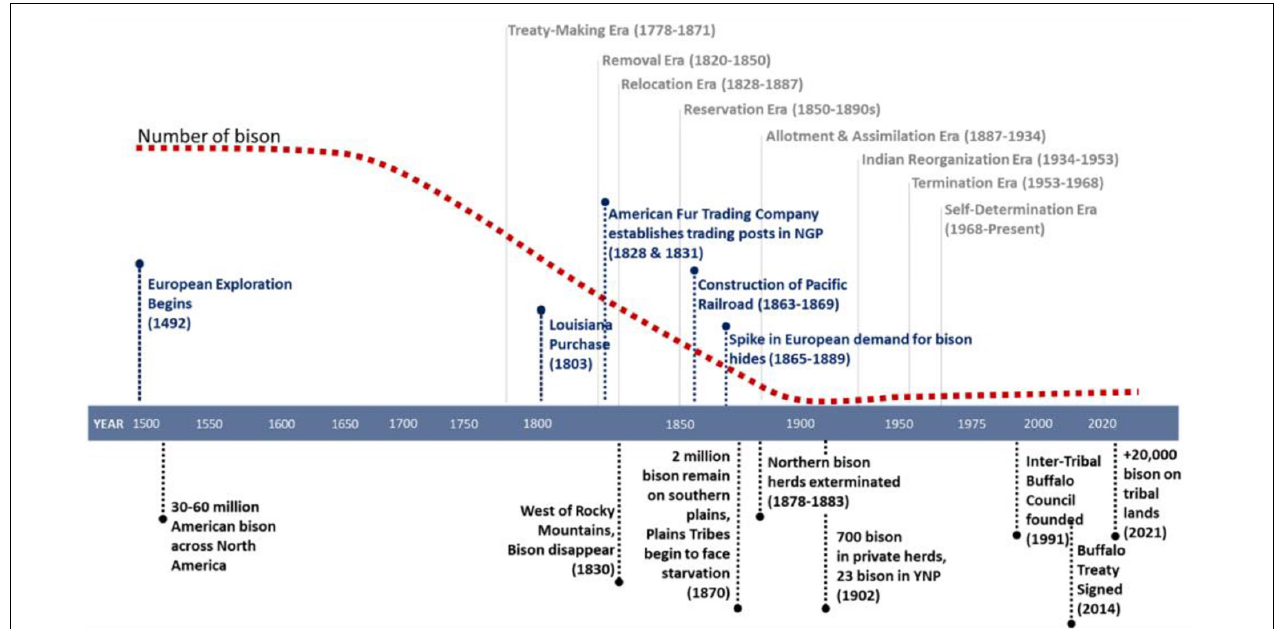
FIGURE 2 | Major events leading to decline of American bison ( Bison bison ) run in parallel with settler colonialism and the disenfranchisement of Plains people. Full details are given in Supplementary Materials (1) . Light gray lines differentiate between Native American eras during European expansions to the West. Dashed blue lines highlight key colonial events that contributed to decline of bison. Black dashed lines highlight key events in the near extermination of American bison (beginning with population estimate). Red dashed line illustrates the decline of bison from 30 to 60 million animals to only a few hundred in the early